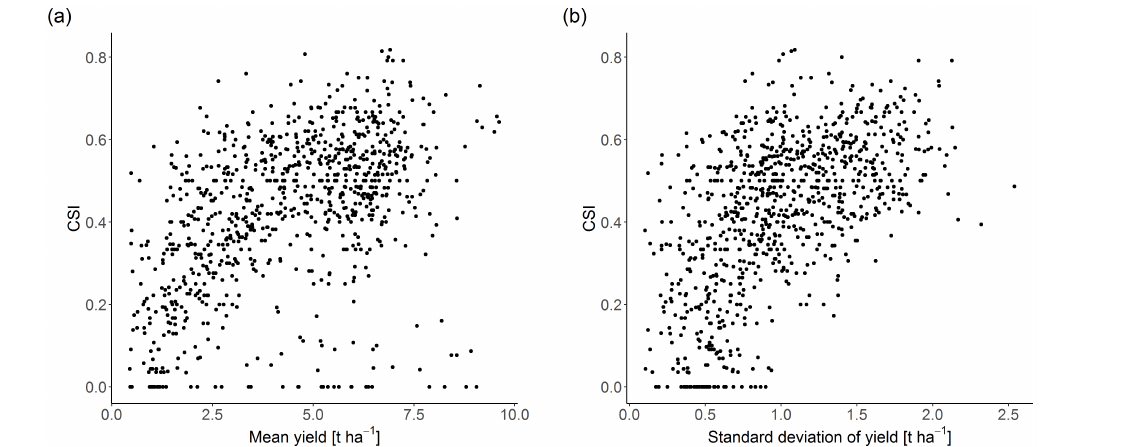
Figure 6. Correlation between CSI and annual crop yield mean and variability for the 889 grid points included in the LASSO logistic regression model. (a) Scatterplot between CSI and mean annual yield. (b) Scatterplot between CSI and annual yield standard